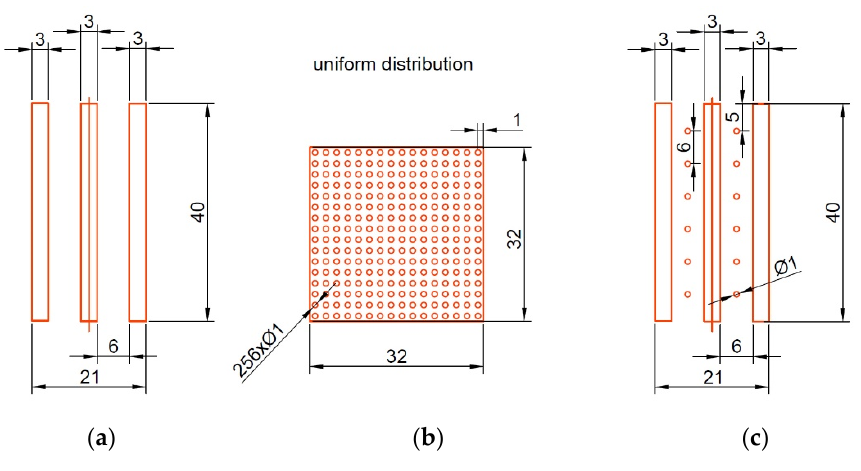
Figure 12. Textured liner surfaces: B ( a ), C ( b ) and D ( c ), after [102].